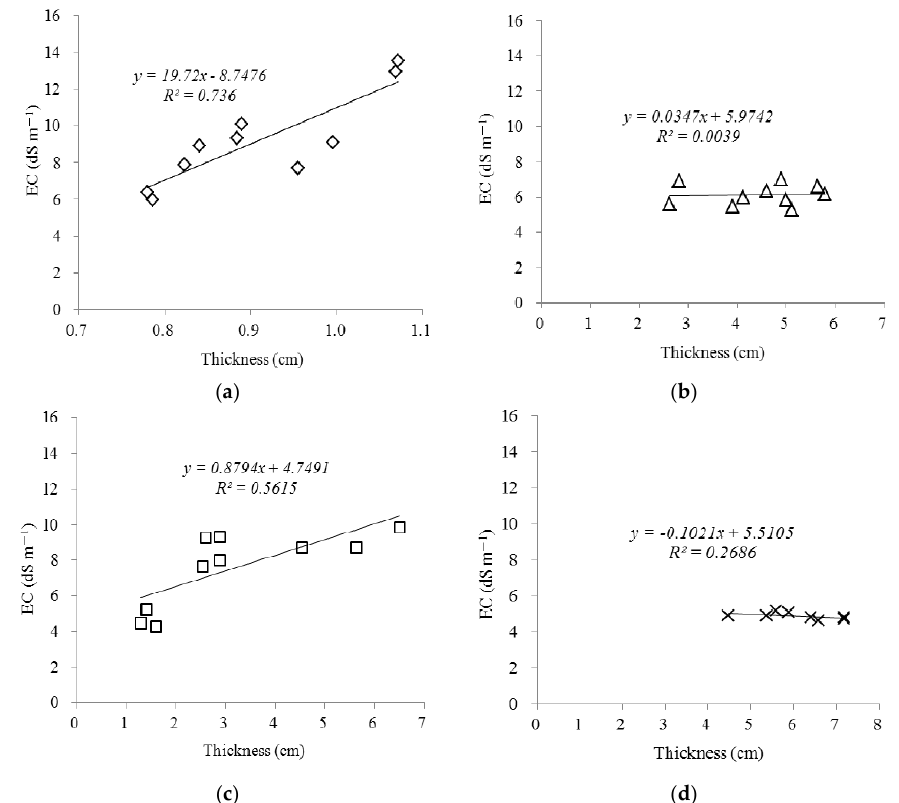
Figure 8. Linear regression relationships between SSCs EC and thickness in shelterbelts planted in different years. ( a ): 1 year; ( b ) 4 years; ( c ) 7 years and ( d ) 10 years. different years. ( a ): 1 year; ( b ) 4 years; ( c ) 7 years and ( d ) 10